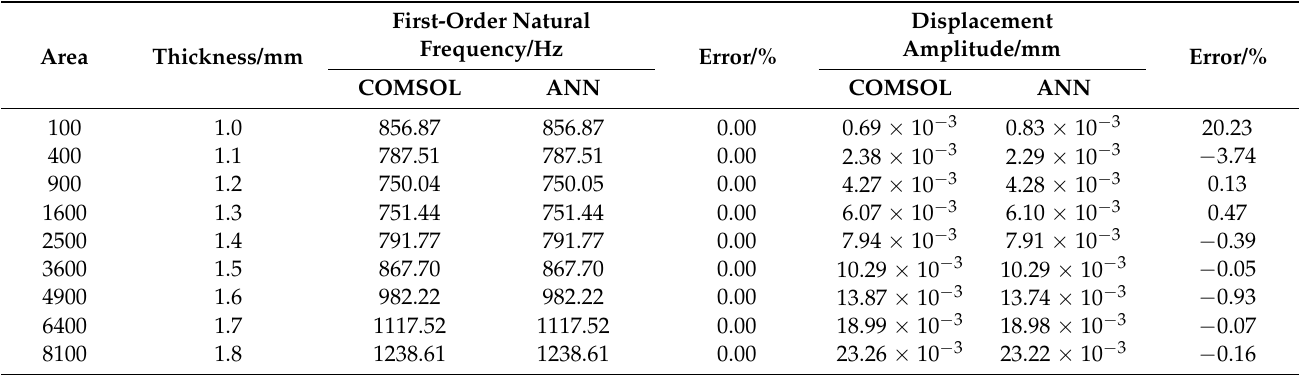
Table 4. Training and predicted results of 2-71-2 ANN model.